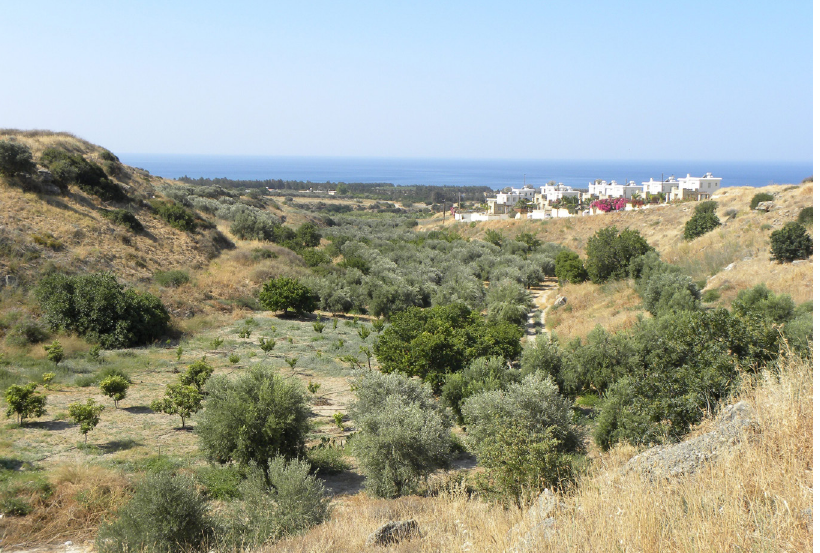
Figure 14. The Loures streambed (looking south towards the coast); to the west rises the Alonia terrace. The sanctuary precinct is to the west of the newly constructed holiday housing. Photo by the author